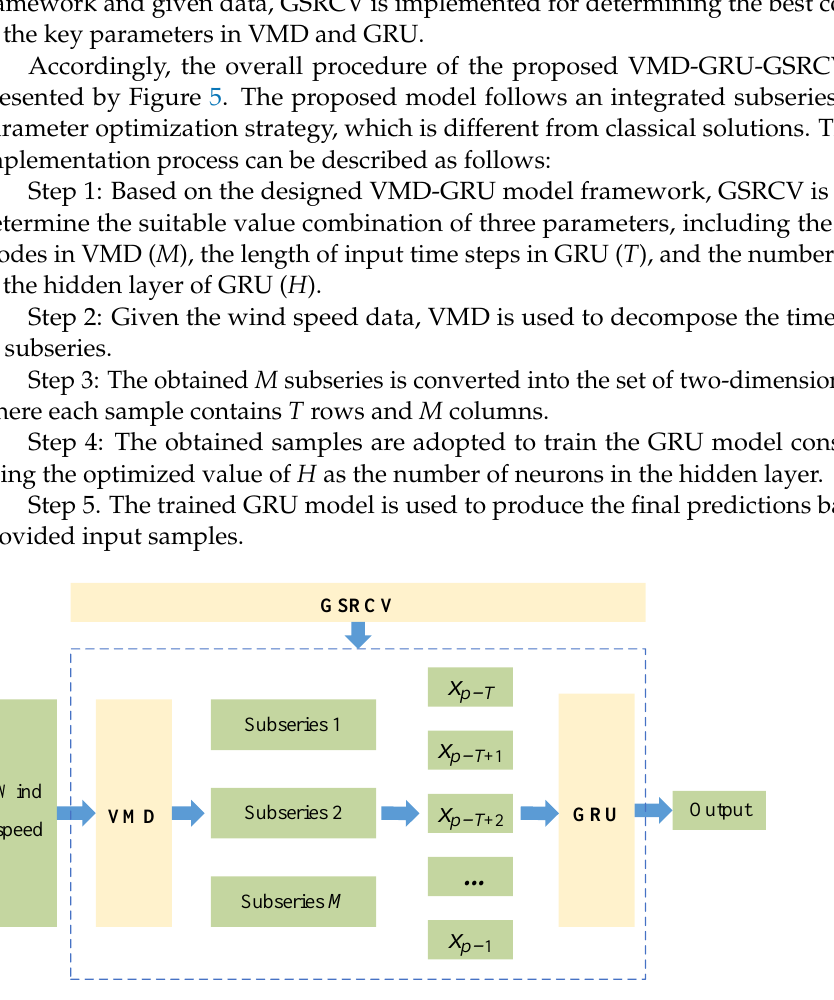
Figure 5. Framework of proposed VMD-GRU-GSRCV model.